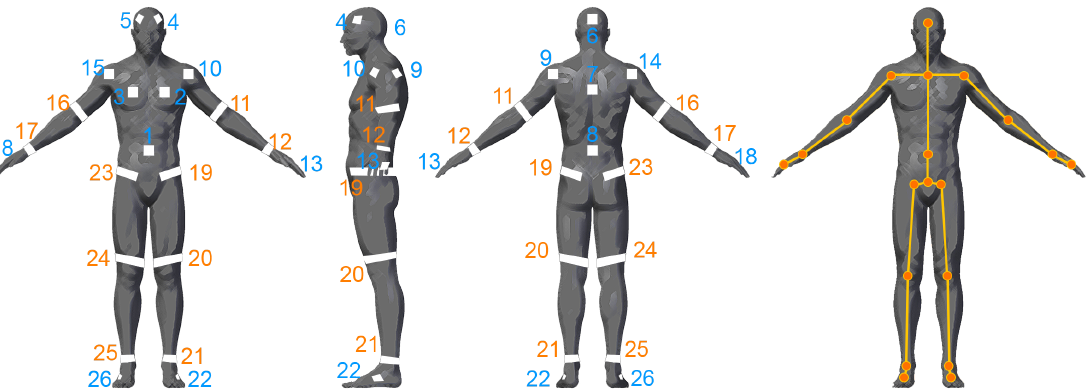
Figure 2. Proposed reflector-set placement. Reflective straps ( orange ) and patches ( blue ) placement on the subject’s